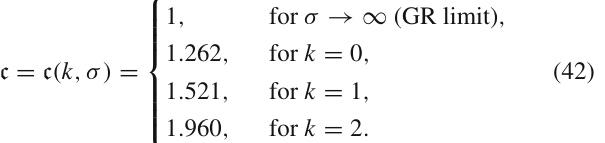
GR limit, and Figs. 5, 6 and 7 take into account the MGD (namely, the EMGD for k = 0), the EMGD for k = 1, and the EMGD for k = 2, with finite brane tension lying in the bound σ (cid:2) 3 . 2 × 10 − 6 GeV 4